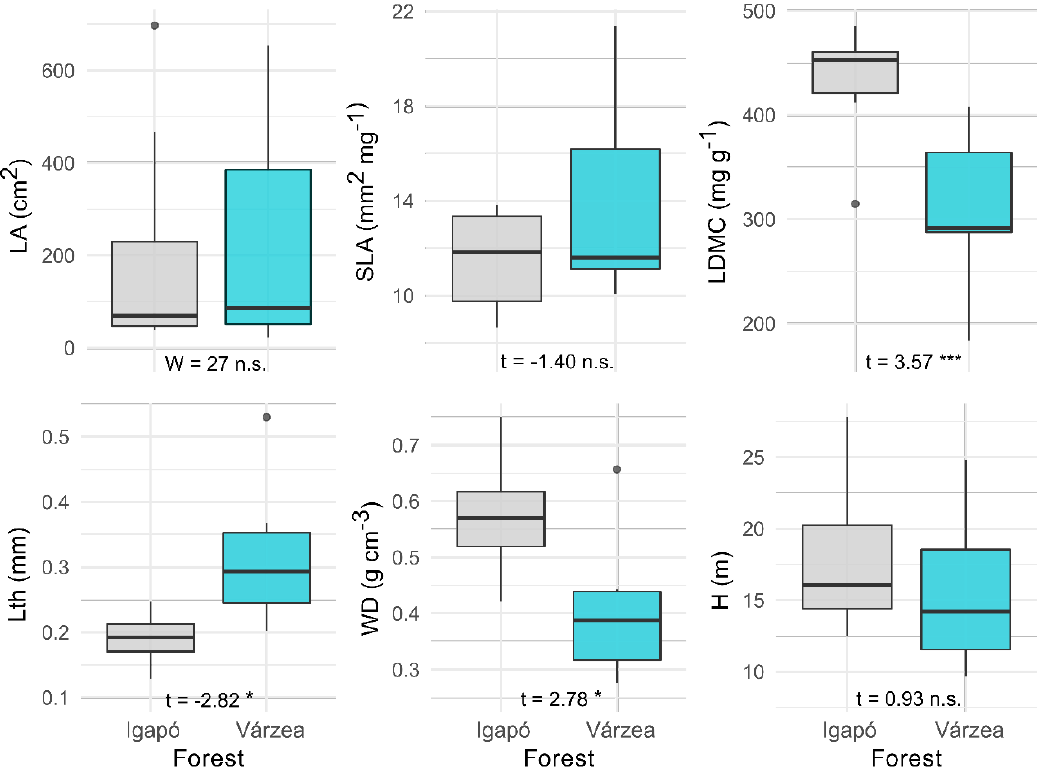
Figure 3. Variation of functional traits within and between the two types of floodplain forest: várzea (blue) and igapó (gray), including the t or W-value according to the test performed (T-test or Wilcoxon test) to compare forest types. Significant differences are considered to exist when p < 0.05; n.s. denotes no significant differences. * represents p < 0.05 and *** represents p < 0.005. LA = leaf area; SLA = specific leaf area; LDMC = leaf dry matter content; Lth = leaf thickness; WD = wood density; H = plant height. The bottom and top of the boxplot indicates the 25th and 75th percentiles (respectively); the horizontal line within the box indicates the median value and the dots indicate outliers. Table 3. Community weighted mean (CWM) trait values (± standard deviation) according to forest type (várzea and igapó) for leaf area (LA), specific leaf area (SLA), leaf dry matter content (LDMC), leaf thickness (Lth), wood density (WD), and plant height (H).